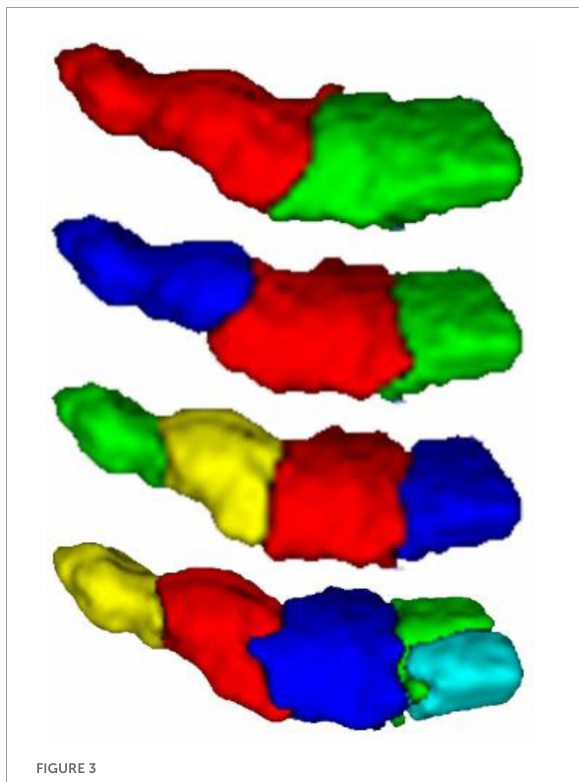
FIGURE3 3D result diagram of different PE subregion schemes. From top to bottom, there are clustering results for brains with 2, 3, 4, and 5.